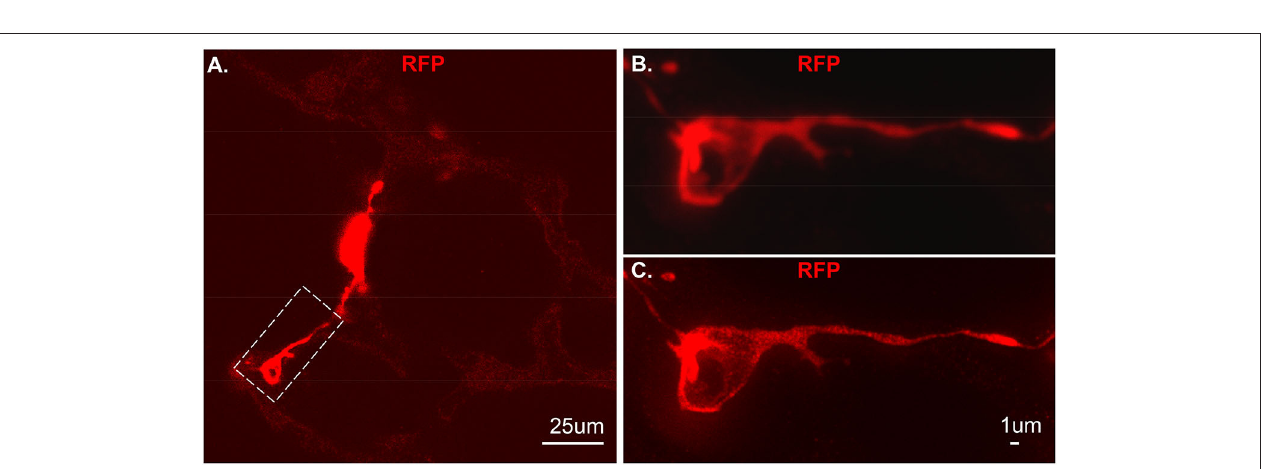
FIGURE 4 | An individual tdT positive cell from vibratome sections. The section was stained using RFP and the secondary antibody used is anti-rabbit-STAR RED. (A) An overall view of NG2-tdT lung using STED. A RFP positive cell in dash rectangle was captured using Confocal (B) or captured using STED (C) . RFP: red fluorescence